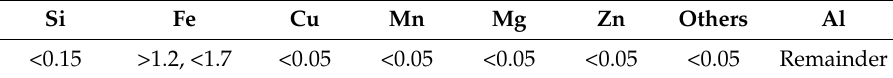
Table 1. Chemical composition of 8021 aluminum foil [wt %].